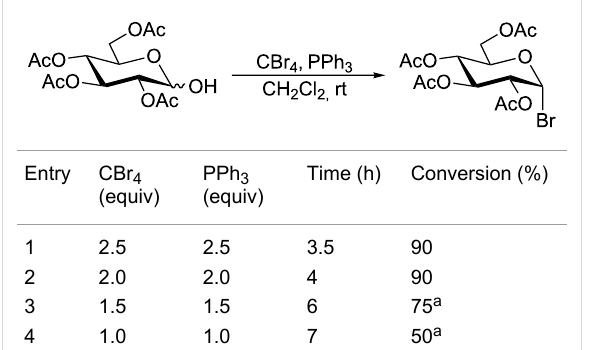
Table 1: Screening of solvents for the in situ conversion of glycosyl hemiacetal to glycosyl bromide.